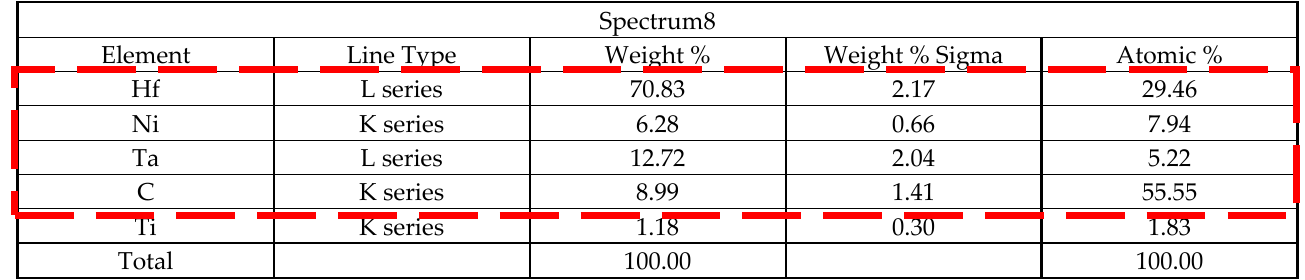
Figure 4. EDS component analysis of Hf distribution of the CM247LC alloy. Table 3. The chemical composition of the superalloy in Spectrum 8.